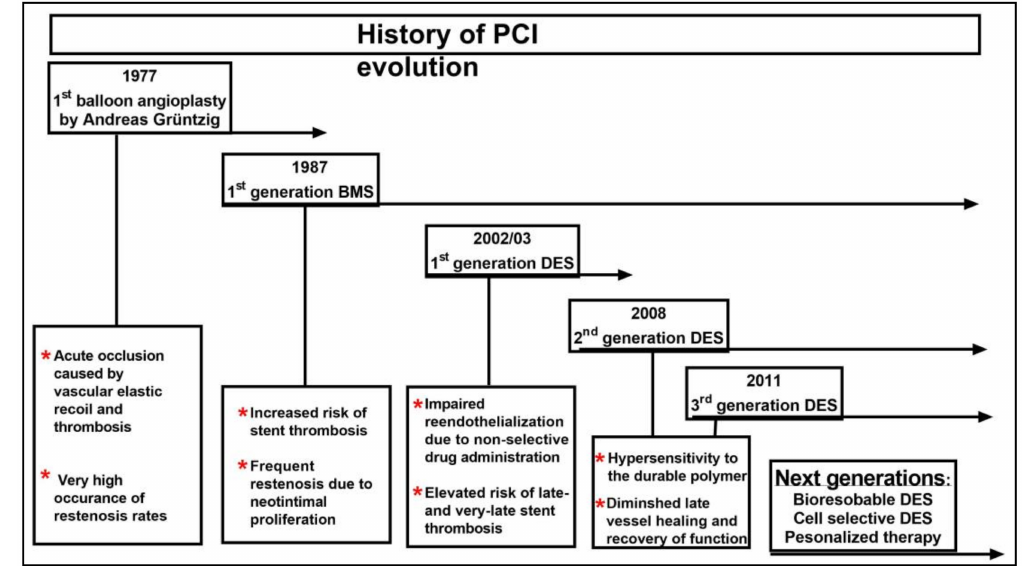
Figure 1. Evolutionary history of percutaneous coronary intervention (PCI). 1 BMS: Bare-metal stent. 2 DES: Drug-eluting